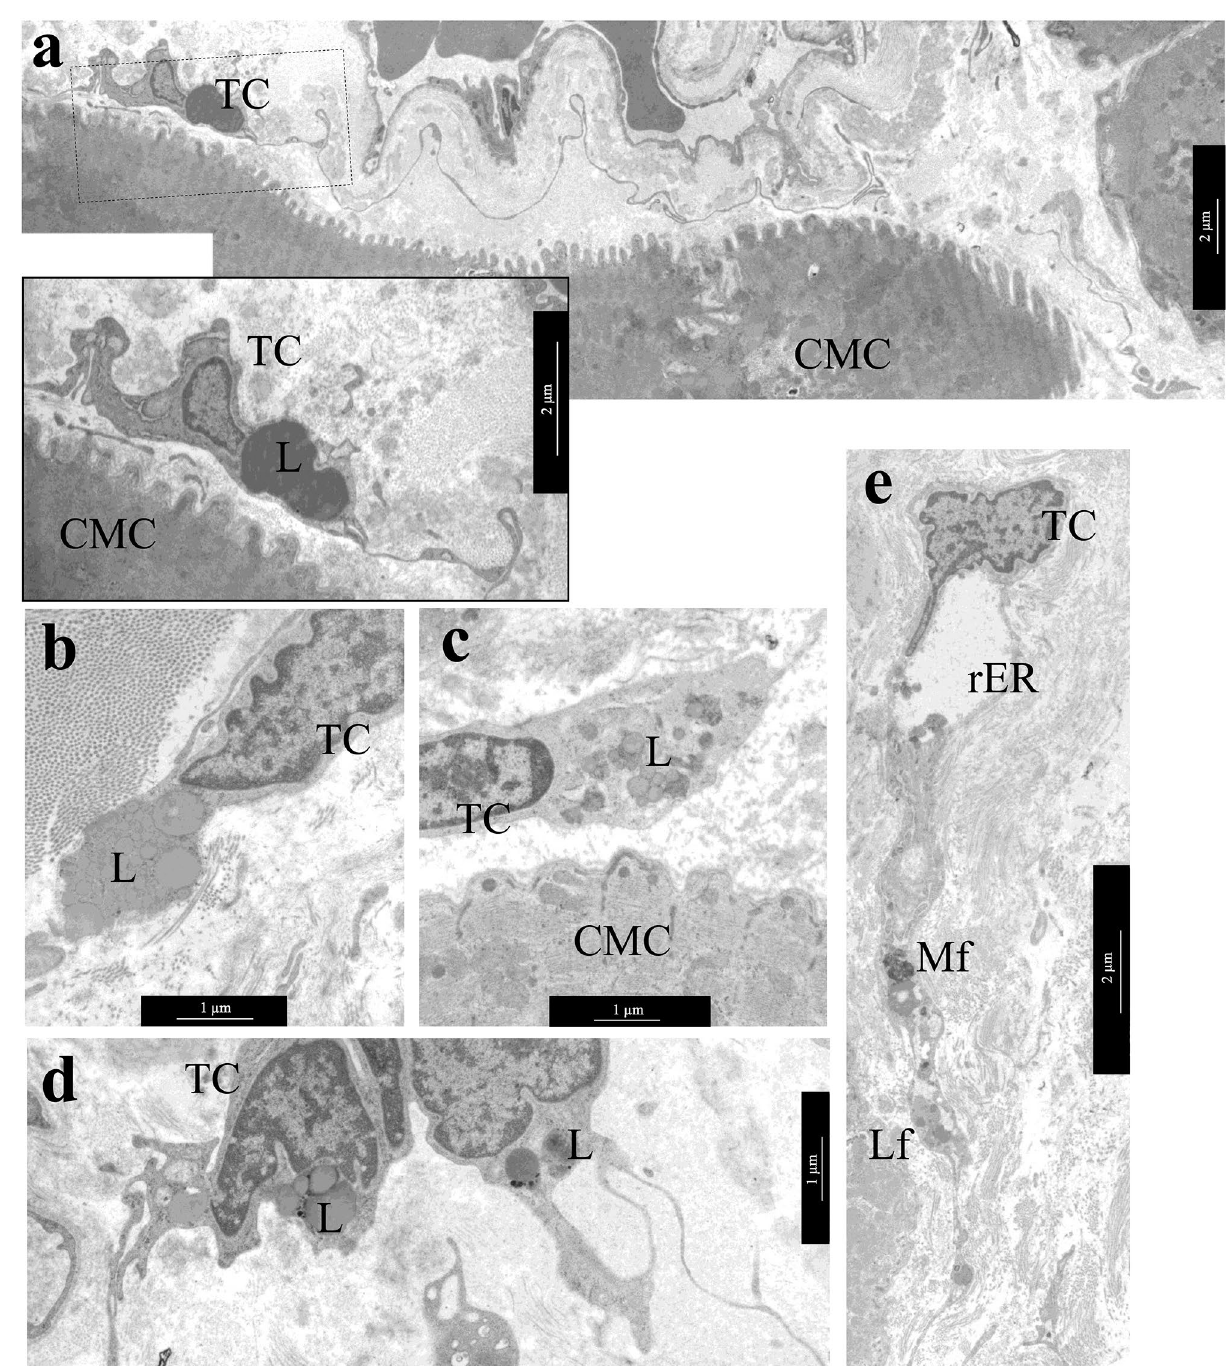
Figure 6. Lipid inclusions and dystrophic changes in atrial appendage myocardial TCs in patients with AF. ( a ) Single lipid inclusions in the perinuclear zone of the TC cytoplasm. bar 1 µm. Insert—bar 2 µm. (b–d ) The accumulation of multiple small and large lipid inclusions in the perinuclear zone of the TCs cytoplasm. bar 1 µm. ( e ) Myelin-like figures (Mf), rough endoplasmic reticulum (rER) and lipofuscin granules (Lf) in the TC cytoplasm. bar 2 µm. TEM. TC—telocyte, CMC—cardiomyocyte. L—lipid